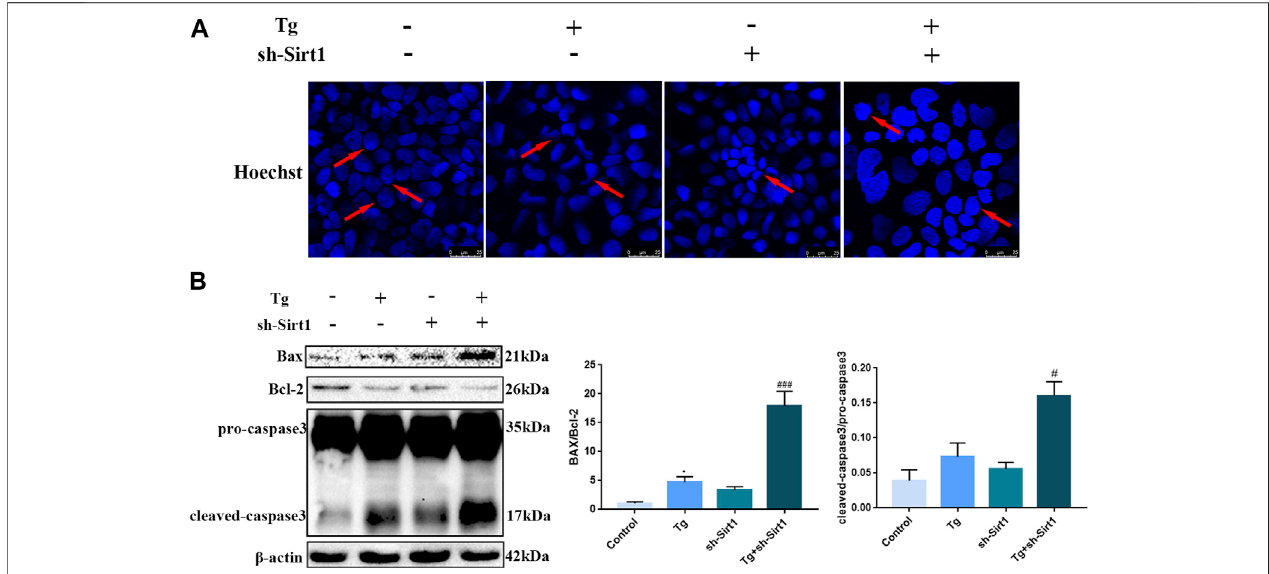
FIGURE6| Theknock-down ofSIRT1 by shRNAincreases the level ofapoptosis inTg-induced Caco-2 cells. (A) Apoptosis wasmeasured in Tg-induced Caco-2 cells using Hoechst staining. (B) Effects of sh-SIRT1 on Bax, Bcl-2 and caspase-3 protein expression levels in Tg-induced Caco-2 cells. Data are presented as the mean±SEM ( n =3). Statistically signi fi cantdifferences areindicated; * p < 0.05, ** p < 0.01,*** p < 0.001,signi fi cantly different fromcontrolgroup. # p < 0.05, ## p < 0.01, ### p < 0.001 signi fi cantly different from Tg group.